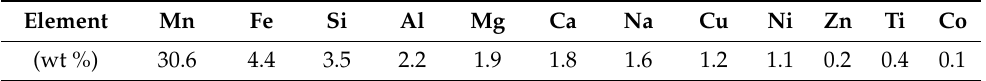
Table 1. The average composition of deep-sea nodules (XRF).